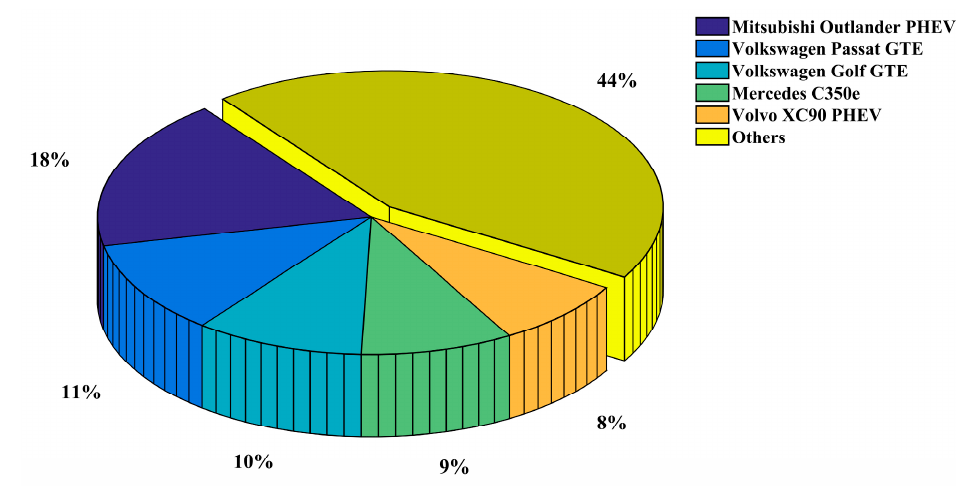
Figure 79. PHEV market shares in Europe in 2016. Data from [193].